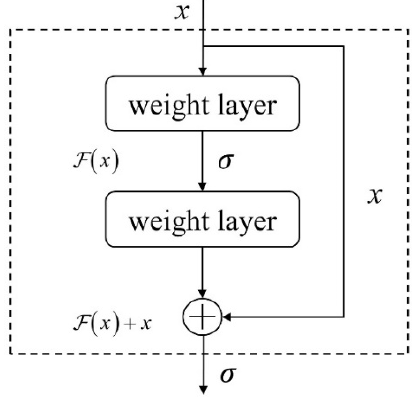
Figure 1. Residual building block. Table 1. Structure of residual networks.